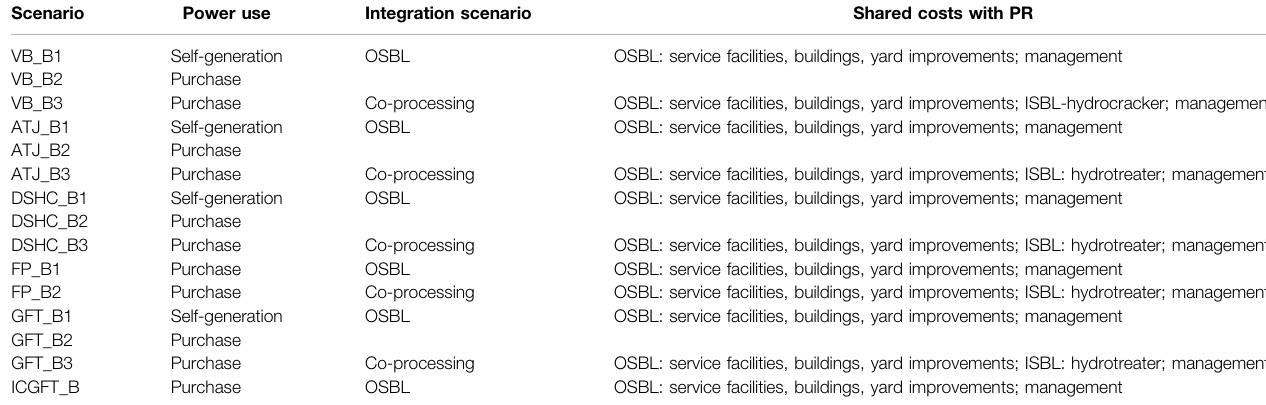
TABLE 3 | De fi ned features of integrated scenarios – co-located; corn stover was the feedstock. Scenario